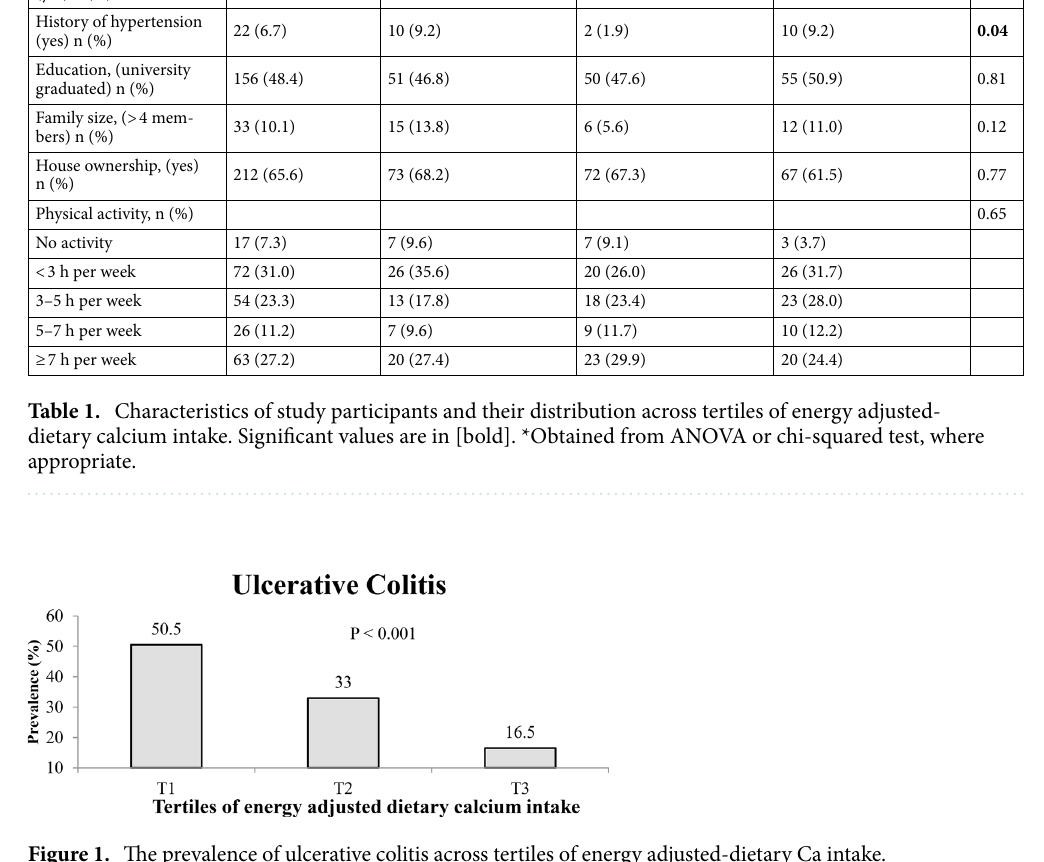
Figure 1. The prevalence of ulcerative colitis across tertiles of energy adjusted-dietary Ca